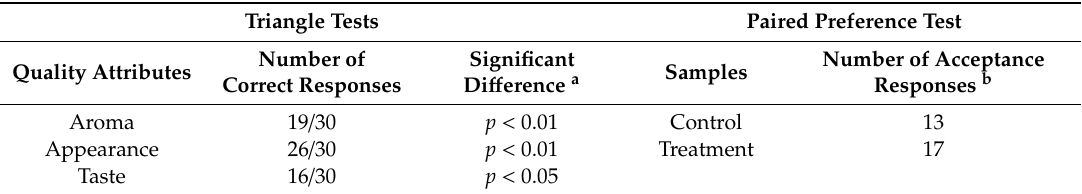
Table 4. The results of triangle and paired preference